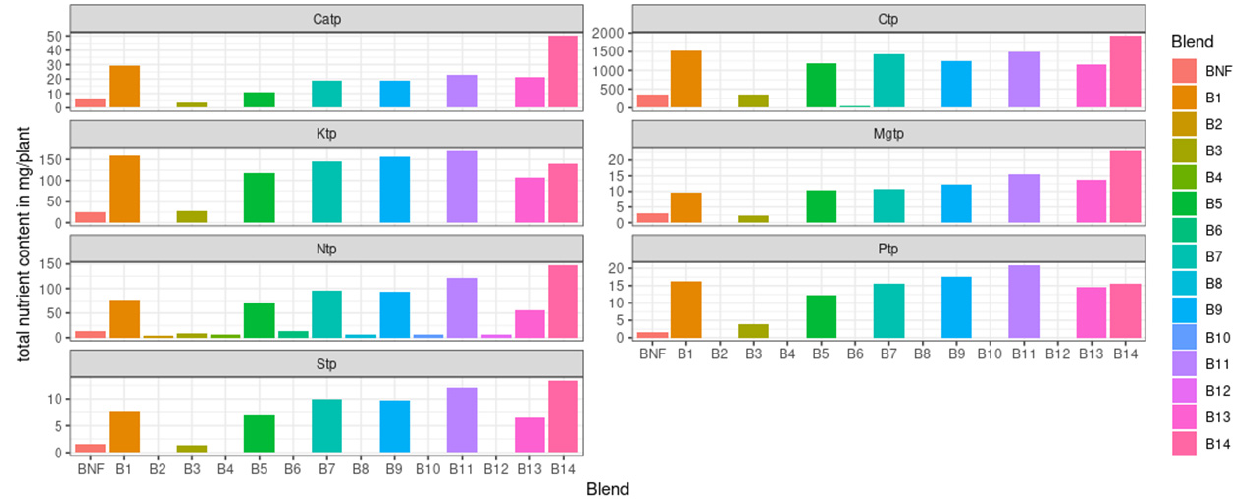
Figure A1. Plant nutrient content (mg plant − 1 ). Table A1. Chemical composition of the different recovered nutrients.